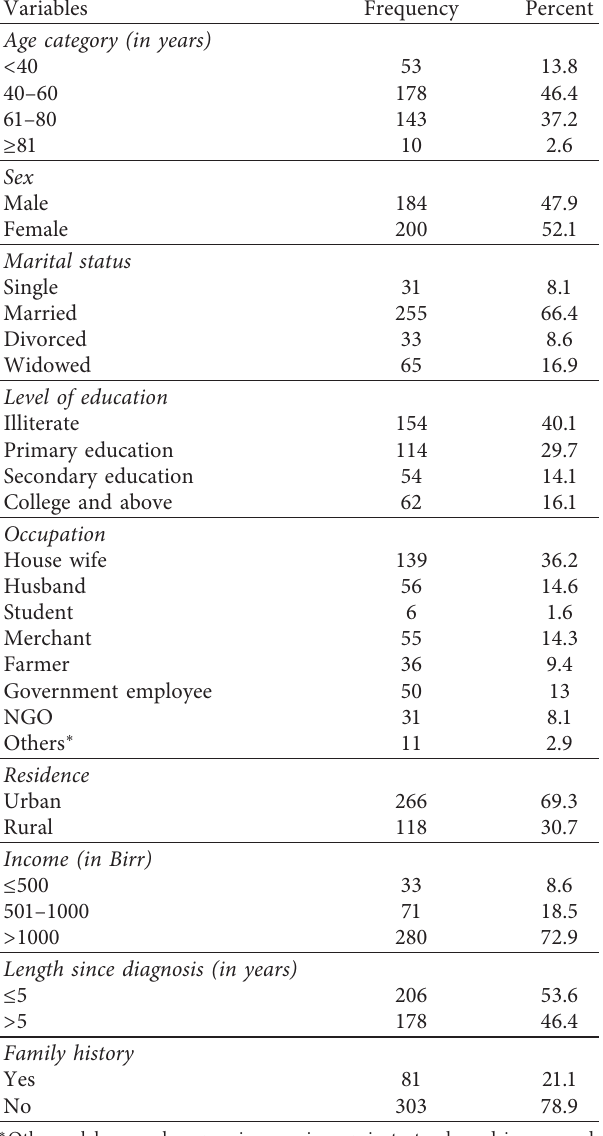
Table 1: Sociodemographic characteristics of hypertensive